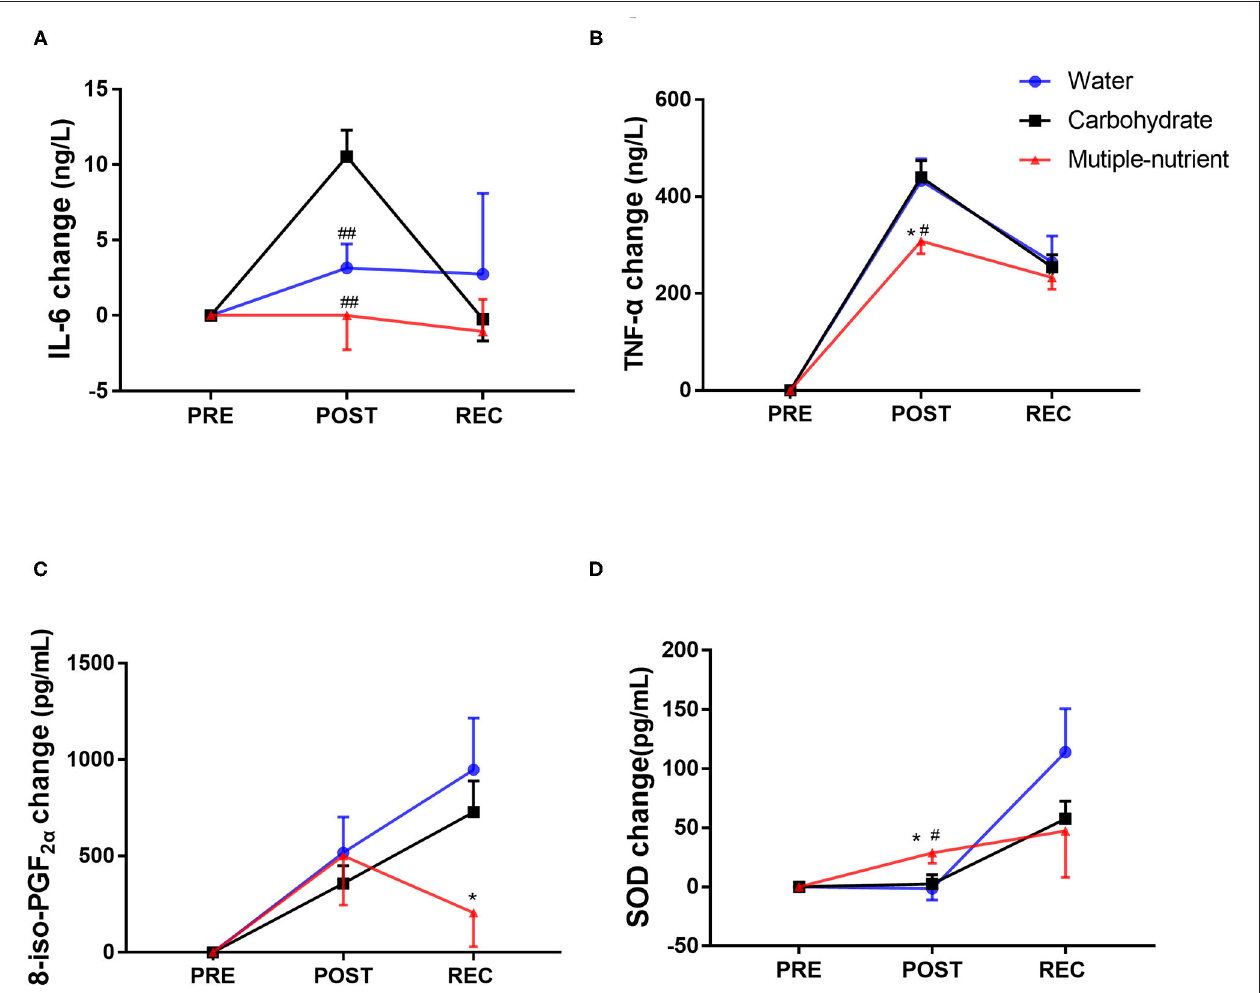
FIGURE 4 | Changes in inflammatory factors and oxidative stress parameters in the short-term supplement trial. Changes in (interleukin 6) IL-6 (A) , tumour necrosis factor- α (TNF- α ) (B) , 8-iso-prostaglandin F (2alpha) (8-iso-PGF2 α ) (C) and superoxide dismutase (SOD) (D) levels in different experimental groups. Values are mean ± SEM. PRE, prior running test; POST, immediately after running test; REC, 24h after running test. Change at POST equals POST minus PRE, change at REC equals REC minus PRE. *Indicates difference compared with water, p < 0.05. # Indicates a difference compared with glucose, p < 0.05, ## Indicates a difference compared with glucose, p <